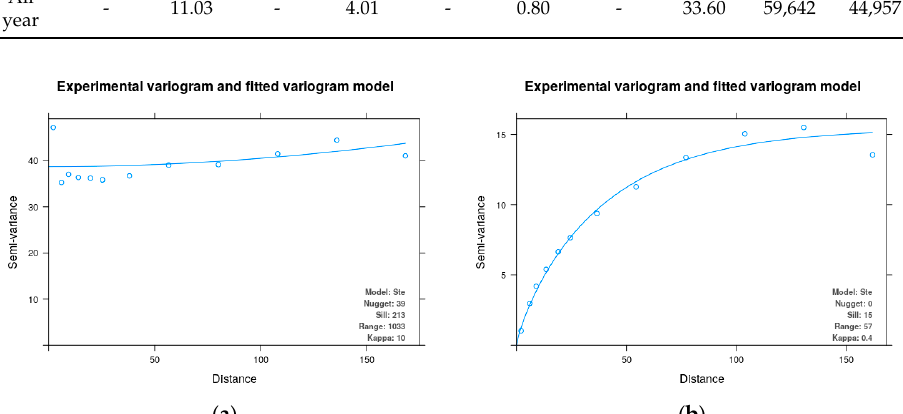
Figure 11. Experimental variograms of 2017 harvest yield at site 1. The best fitted variogram model was selected based on the smallest sum of square: ( a ) before spatial filtering (Model: Ste; Nugget: 39; Range: 1033); ( b ) after spatial filtering (Model: Ste; Nugget: 0; Range: